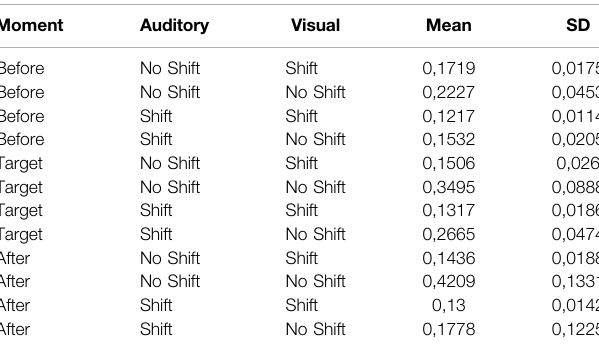
TABLE 2 | Means and standard deviations for fi xation duration (ms) per area of 100 pixels as function of the period and auditory/visual perspective shift (no Shift (He/He), Shift (He/I) (N =